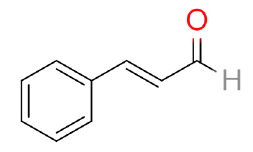
Figure 1. Chemical structure of cinnamaldehyde.